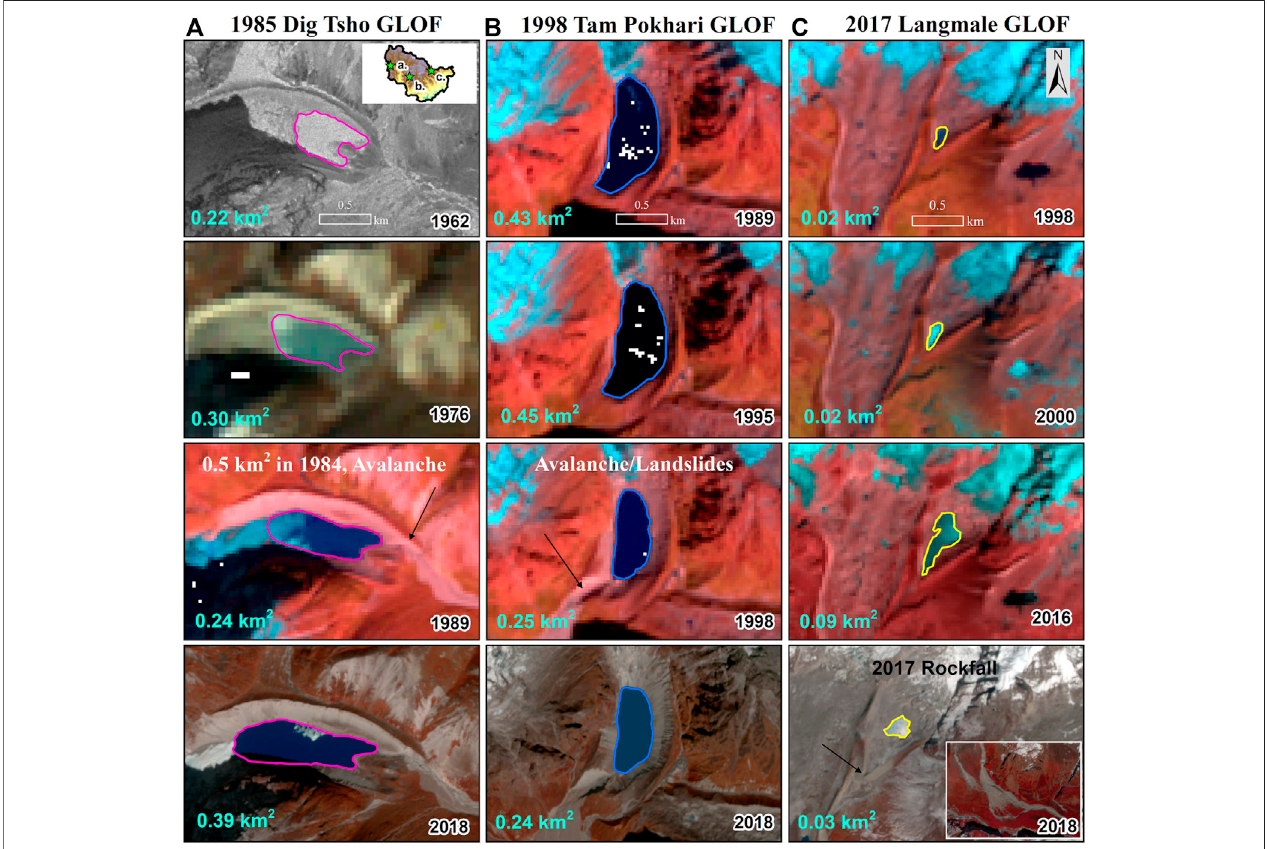
FIGURE 3 | The (A) Dig Tsho, (B) Tam Pokhari and (C) Langmale glacial lakes at different stages before and after their outburst and at present (2018). The arrow showsthev-shapedtrenchwithdebrisoutcropsrevealingtheevidenceofpastGLOF.ThebackgroundimagesarefromCorona(1962),Sentinel-2(2018)andremaining from Landsat TM/OLI.